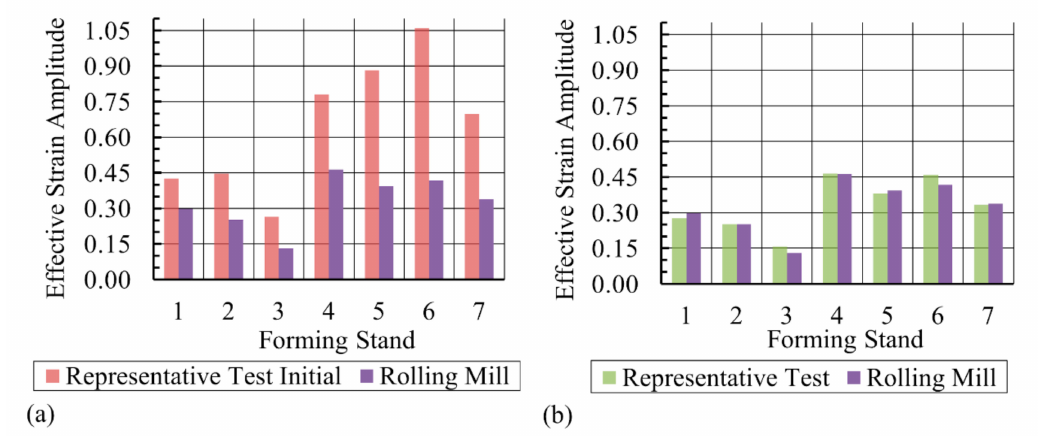
Figure 8. ( a ) E ff ective strain amplitude comparison between the initial representative test and the rolling mill simulations and ( b ) between the corrected representative test and the rolling mill